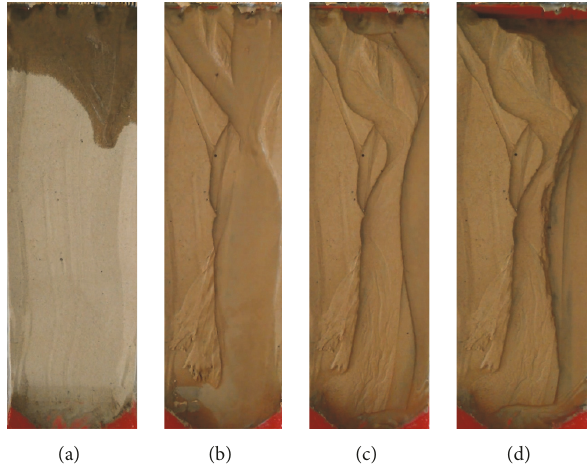
Figure 12: The failure pattern of unreinforced specimen: (a) development stage; (b) failure stage 1; (c) failure stage 2; (d) stable